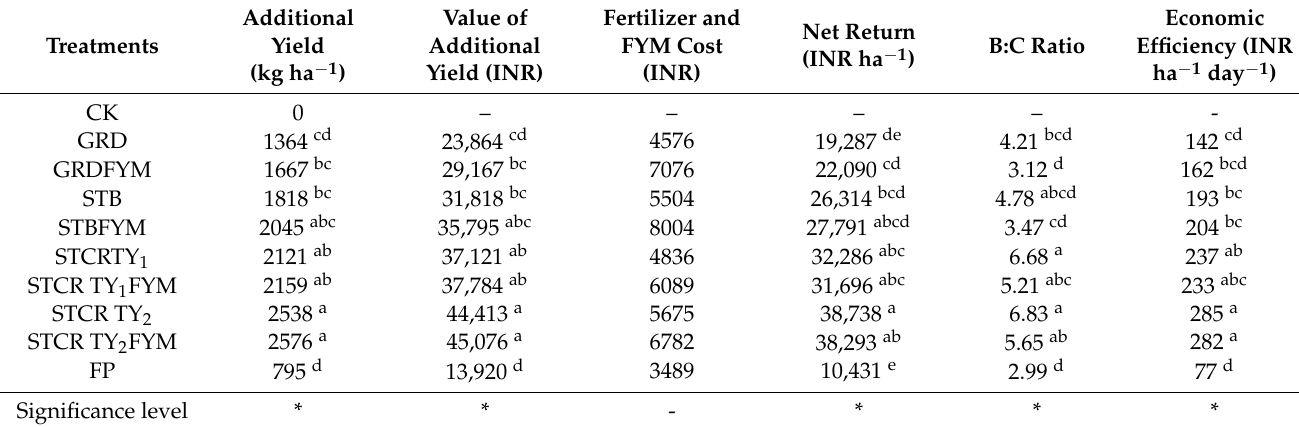
Table 9. Fertilizer-economics in DSR under different treatments.